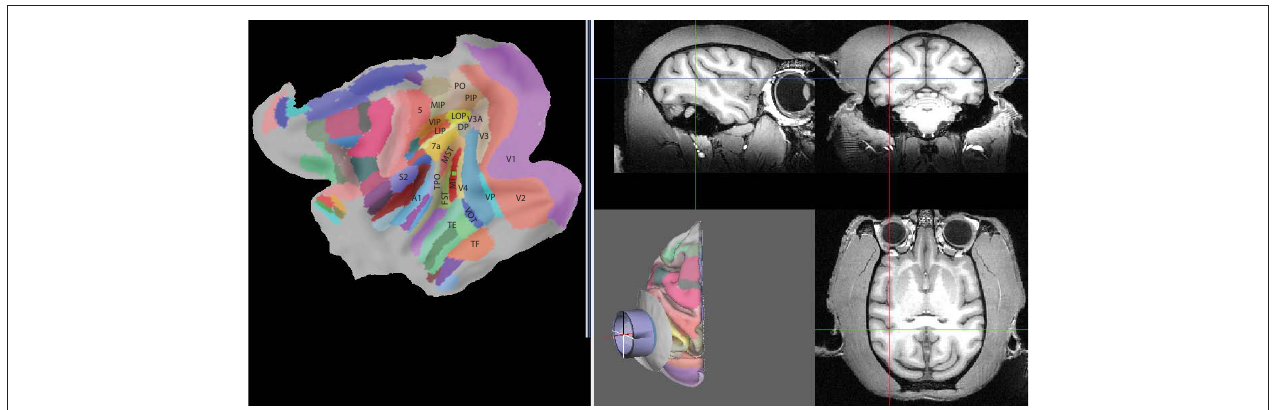
the structural MRI on the right side with the cross-hair cursors. The central panel on the gray background shows the cortical hemisphere in 3D (with identified areas again being marked in color), a circular part of the outer skull surface (light gray), and a recording chamber (blue) that has been placed according to SPLASh’s default placement algorithm.